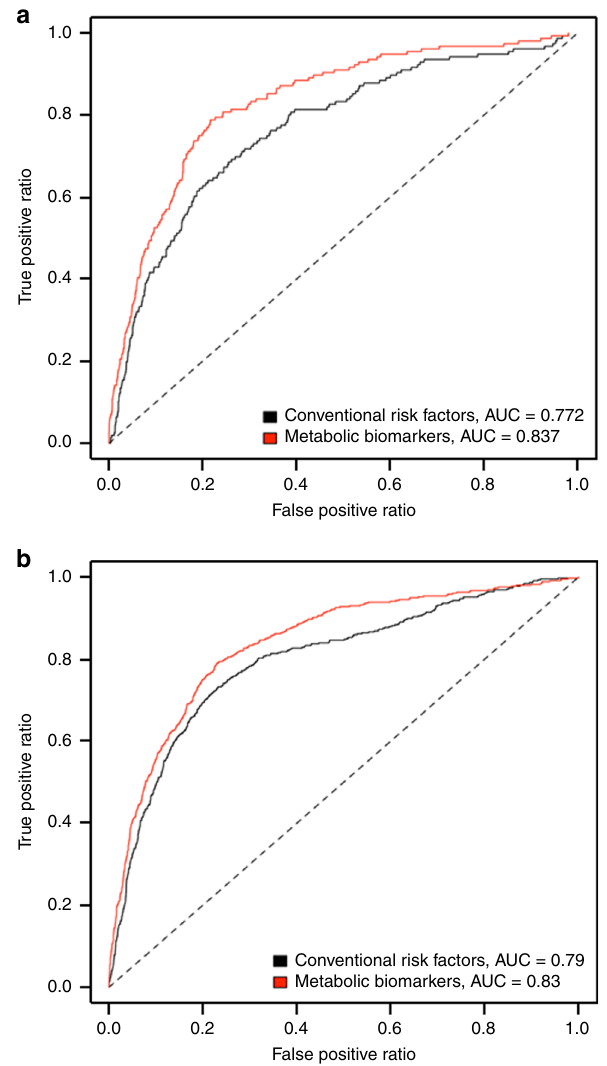
Fig. 1 Mortality risk prediction accuracy of the 14 identi fi ed metabolic biomarkers. Receiver operating characteristic curves for 5- ( a ) and 10-year ( b ) mortality in the FINRISK 1997 cohort. The curves are based on the predictions from the conventional risk factors (black) and the metabolic biomarkers (red). AUC area under the